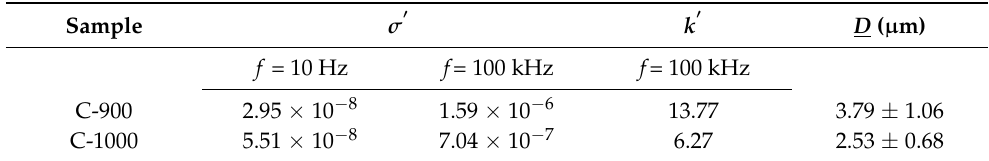
Table 2. Dielectric constant and real electrical conductivity measurements of ceramic samples C-900 and C-1000 performed at 10 Hz and/or 100 kHz at room temperature.